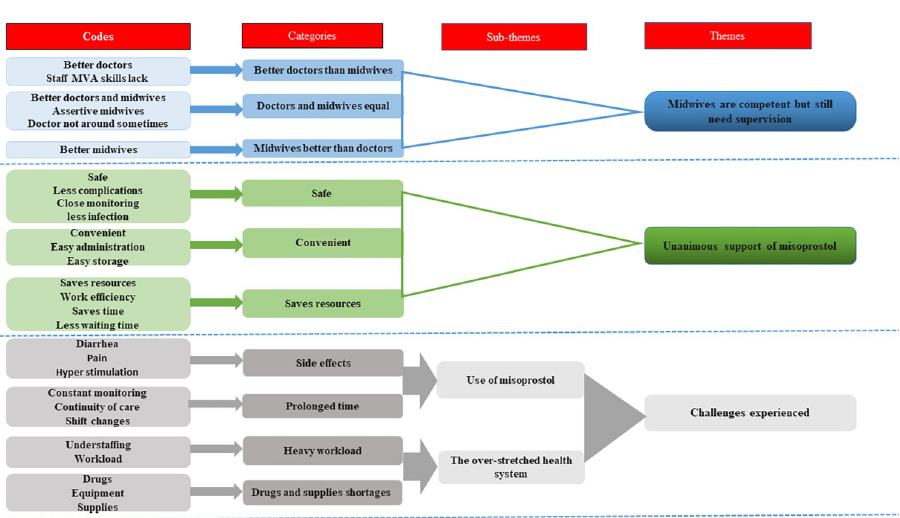
Fig 1. An example of the abstraction process- generation of themes from the codes. MVA–Manual vacuum aspiration.